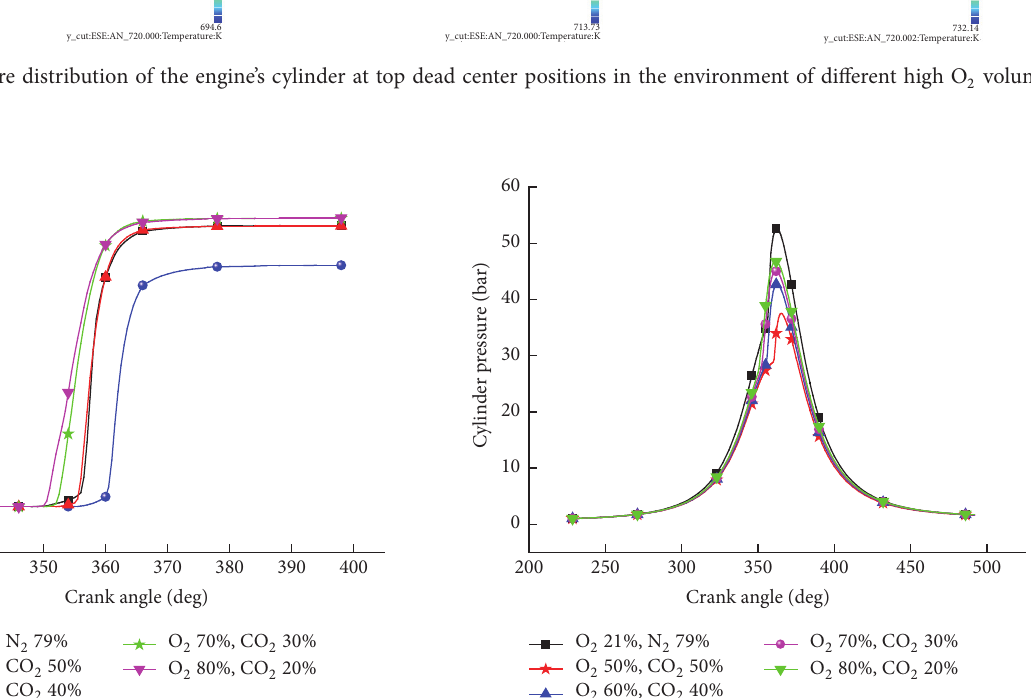
Figure 11: Cylinder pressure in the environment of different high O 2 volume